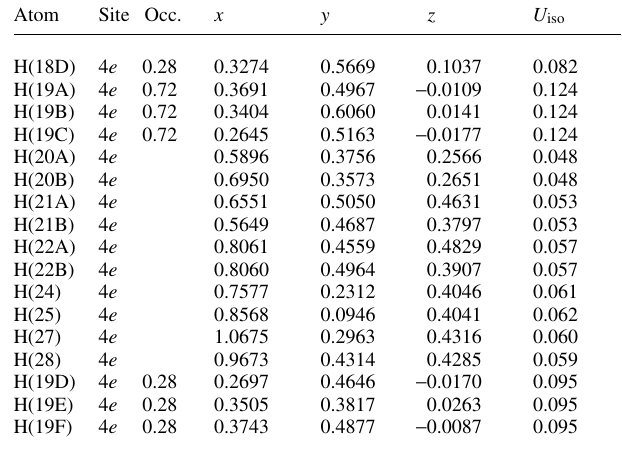
Table 2. Atomic coordinates and displacement parameters (in Å 2 ) . Atom Site